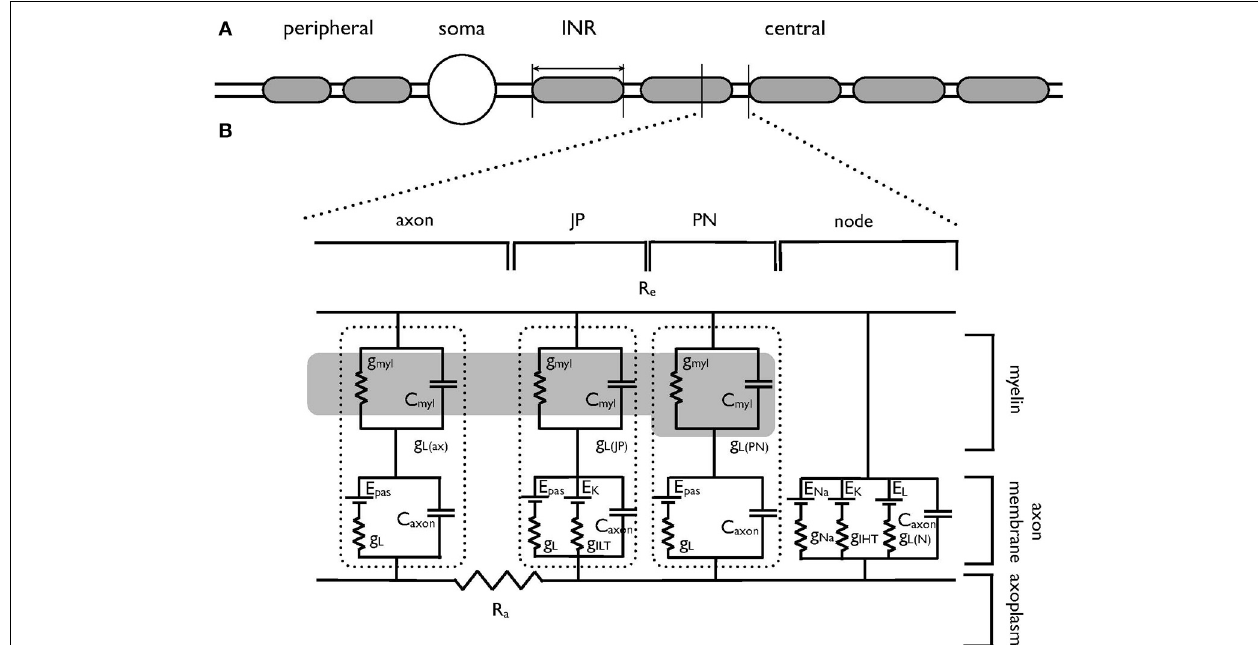
FIGURE 1 | Schematic model of the auditory nerve. (A) The auditory nerve fiber is divided into three distinct regions. The peripheral axonal region terminates in the organ of Corti. The soma resides in the spiral ganglion. The central axon projects to the cochlear nucleus, is myelinated with internodal myelinated regions modeled as 100 μ m in length. (B) Equivalent circuit of the central portion of the auditory nerve, which has been adapted from an existing model of corpus callosum axon (Tagoe et al., 2014). The morphological and electrical values are contained in Tables 1 , 2 respectively. The axon is divided into the nodal region and the internodal region. The internodal region is subdivided into the paranodal (PN) juxtaparanodal (JP) and axonal regions (axon). The nodal region expresses the voltage-dependent